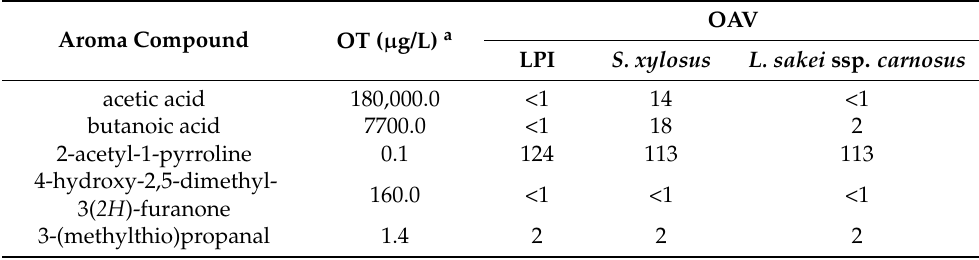
Table 4. Odor activity values (OAVs) of six selected aroma compounds calculated based on